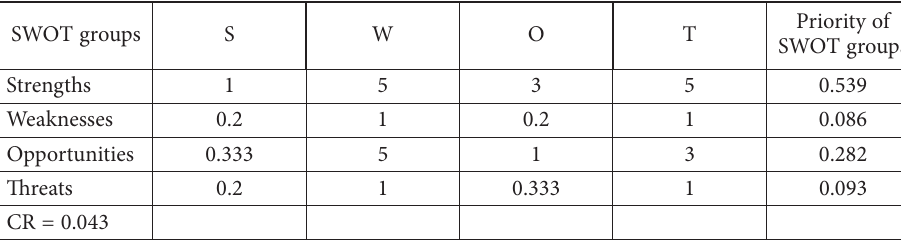
Table 6. Priorities of the SWOT groups and consistency